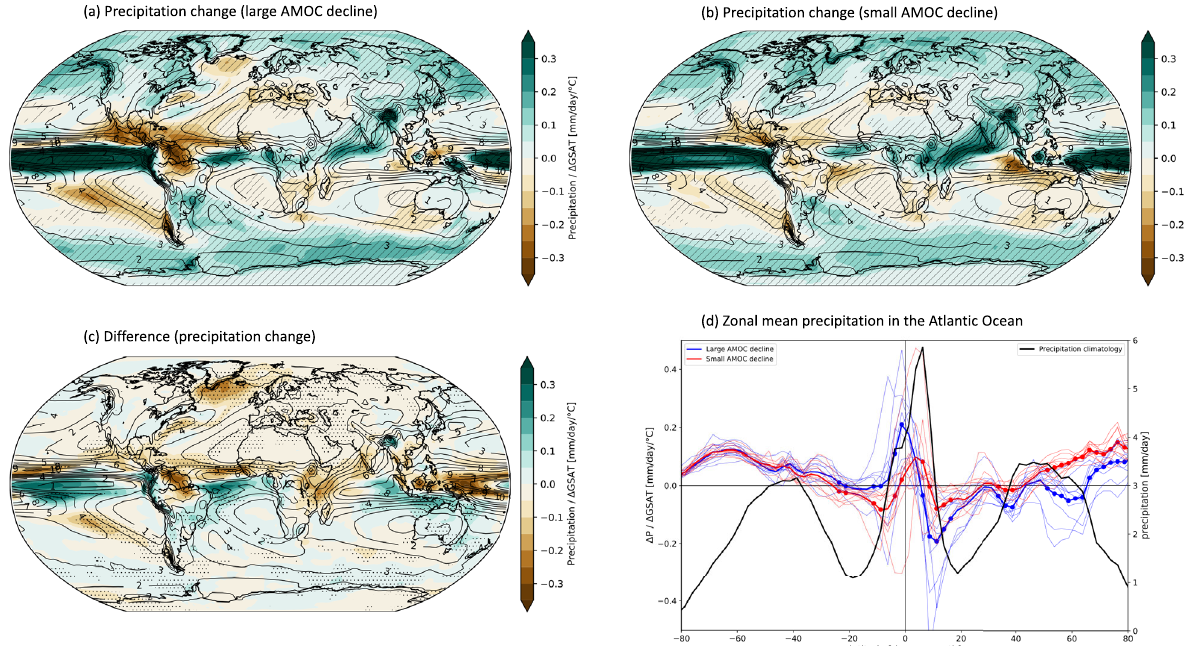
Fig. 3 Precipitation change associated with AMOC. Panels a , b show the normalized annual mean precipitation change in the abrupt-4xCO 2 with respect to the preindustrial control for a the average of the large AMOC decline group and b the average of the small AMOC decline group. Panel c is their difference (a minus b). For each model, precipitation change ( Δ P) is divided by the respective Δ GSAT, hence the units are mm/day per degree of global warming. In panels a – c , superimposed contours show the climatological mean precipitation computed from all models. Panel d shows the zonal mean precipitation change in the North Atlantic sector in the (blue) large AMOC decline group and (red) small AMOC decline group. Thick lines are the group averages, while thin lines show each group member. Round markers indicate where the Student ’ s t -test between the means of the two groups is signi fi cant at the 90% level. The black line is the zonal mean precipitation climatology computed from the preindustrial control of all models: units are of mm/day and the corresponding scale is located on right-side